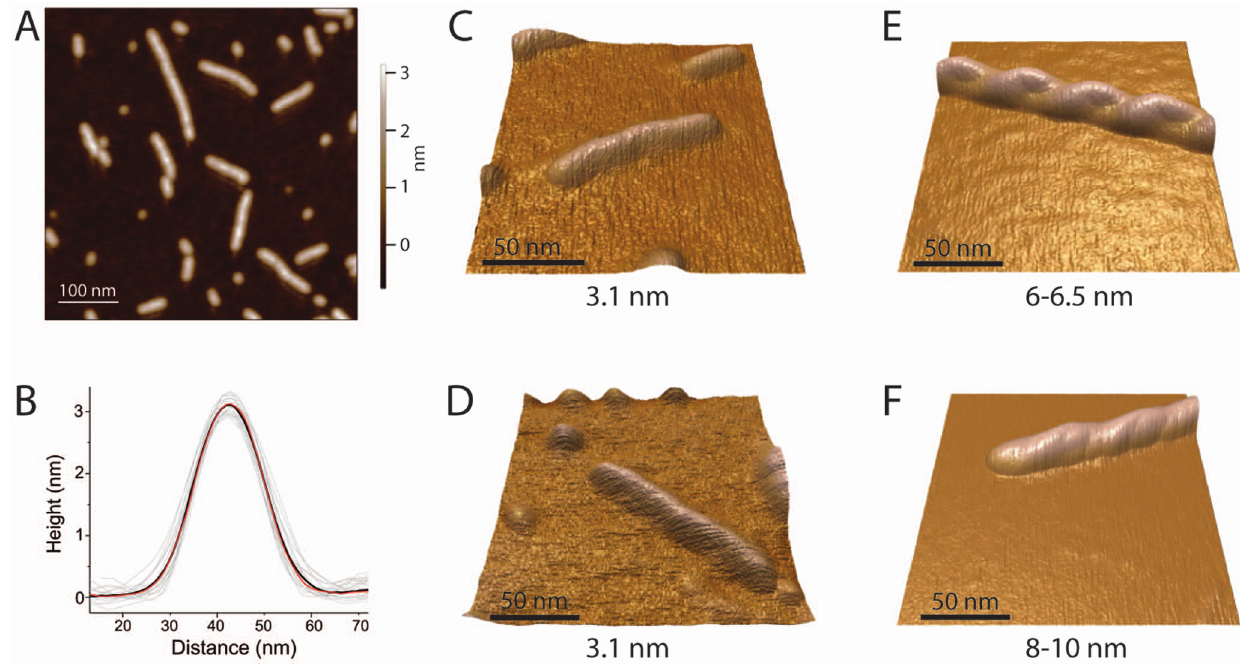
Figure 1. Analysis of A b 42 CC morphology using atomic force microscopy (AFM). (A) AFM image of A b 42 CC protofibrils on dry mica surface. (B) Average z -heights and cross-sections of A b 42 CC (black) and wild type A b 42 (red) protofibrils (grey lines represent measurements of 20 A b 42 CC protofibrils). (C-F) High magnification AFM images of single protofibrils of A b 42 CC (C) and wild type A b 42 (D; identified in aggregation reaction mixtures, Fig. S2), and of amyloid fibrils of A b 40 (E) and A b 42 (F). Measured z -heights of particles are indicated in panels C-F.